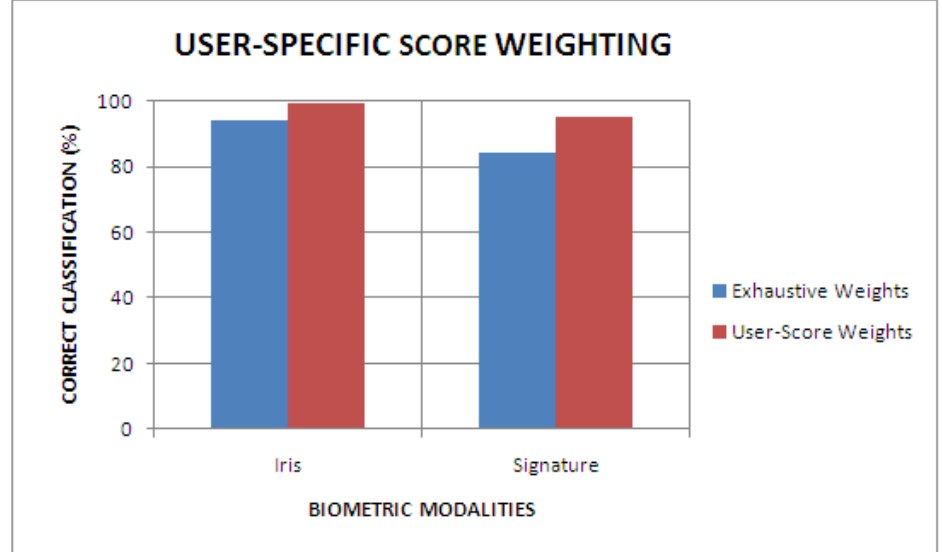
Figure 3. Average true positive rate of the iris and signature